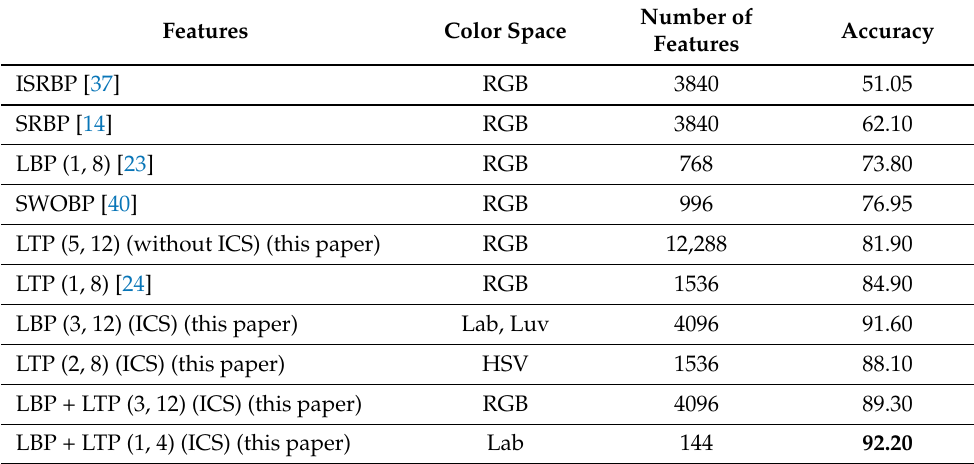
Figure 7. Highest results obtained on the Cloud-ImVN 1.0 dataset without (first row) and with (second row) histogram selection method. Table 6. Comparison of experimental results on the Cloud-ImVN 1.0